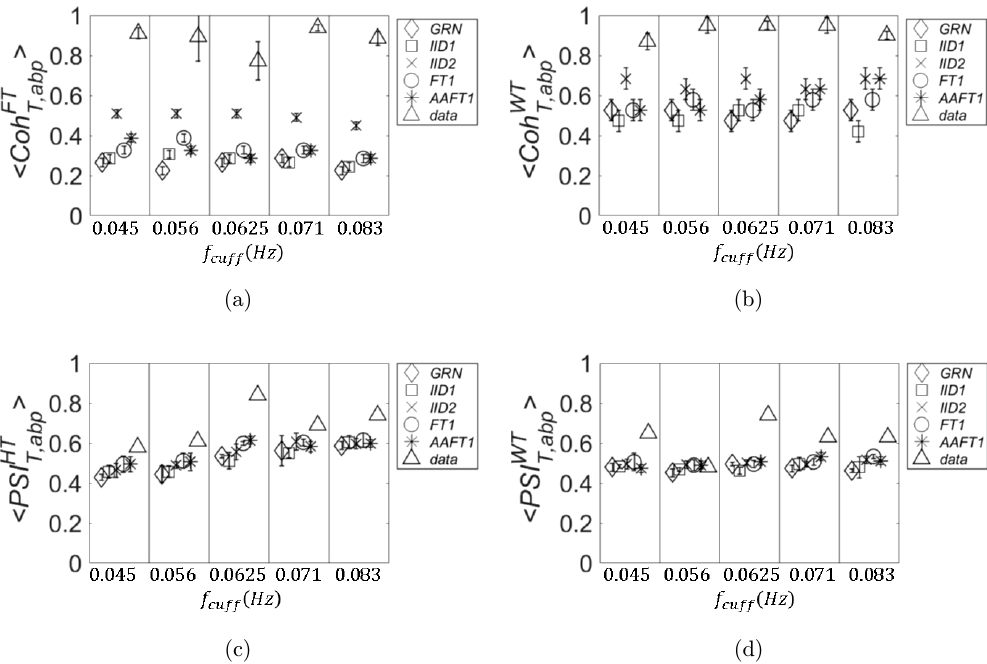
Fig. 3. The threshold values of coherence and PSI are shown for ¯ve di®erent methods to generate surrogate data together with the values calculated for an experimental data set in vivo (subject 1). The x axis is de¯ned as in Fig. 2. Speci¯cally, in the four panels are plotted: linear coherence (a), wavelet coherence (b), PSI calculated with analytic signal (c), and PSI calculated with wavelet cross spectrum (d). The methods for surrogate data are: GRN (diamonds), IID1 (squares), IID2 (crosses), FT1 (circles), and AAFT 1 (asterisks). The experimental data are represented by